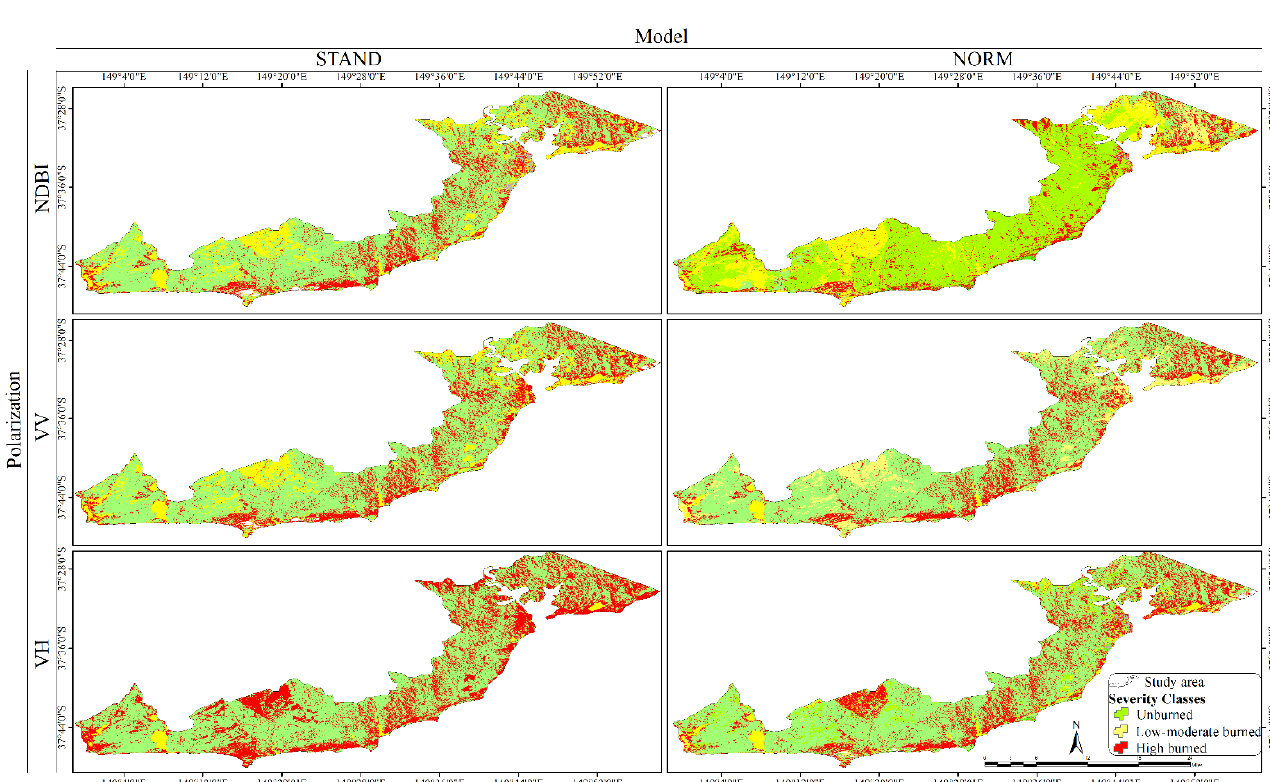
Figure A2. Mean of dry and wet condition.